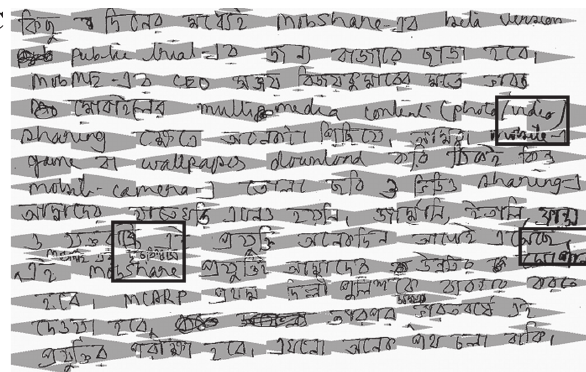
Figure 12. (A–C) Sample Document Images Where the Current Technique Fails to Successfully Separate Text Line from Docu- ment Images. Regions Where Such Error Occurs are Highlighted in Rectangular